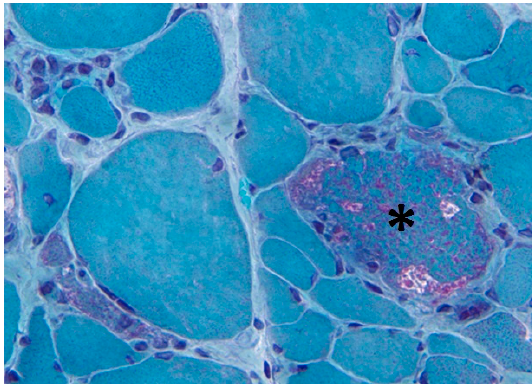
Figure 2. Modified Gomori trichrome stain showing a ragged red fibre. A ragged red fibre (asterisk) is present in the quadriceps muscle biopsy of a 67 years old female sporadic inclusion body myositis patient. Magnification ×785 before reduction.